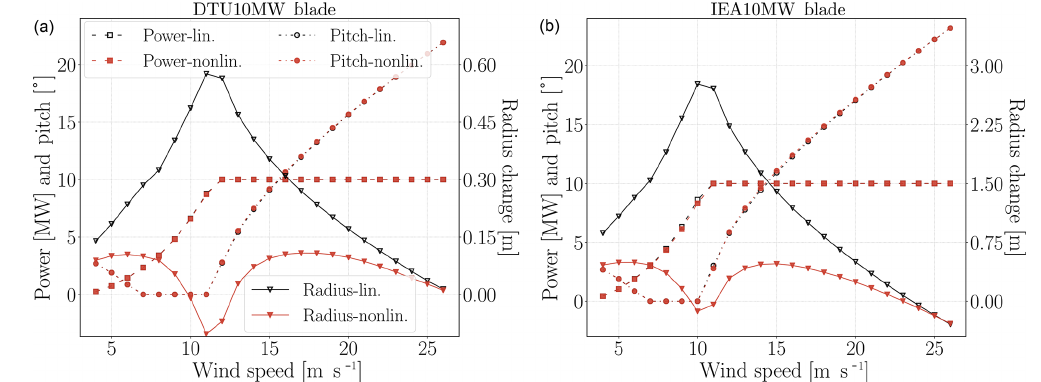
Figure 3. Linear and nonlinear blade model power, blade pitch (left axis in the figures) and effective blade radius change (right axis in the figures) results with respect to wind speeds for steady-wind-load cases. Panel (a) shows the DTU10MW results and IEA results are given in (b) .